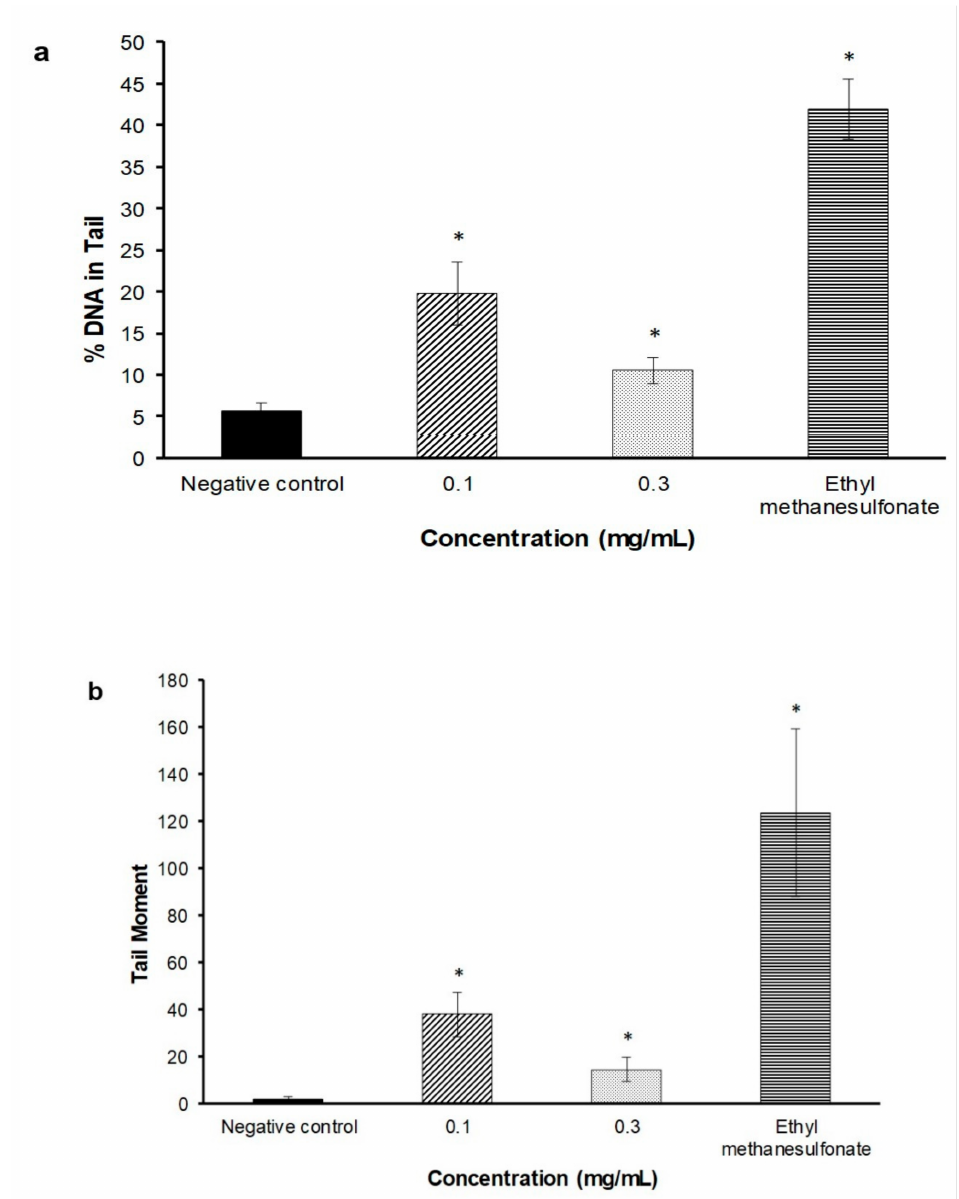
Figure 3. The DNA damage induction in V79B cells measured by alkaline comet assay after cells were treated either with FDAE or positive control (Ethyl methanesulfonate) for 2 h. DNA damage is expressed as ( a ): % DNA in tail and ( b ): tail moment. Data was expressed as mean ± SEM. * is where p value is < 0.05 as compared to negative